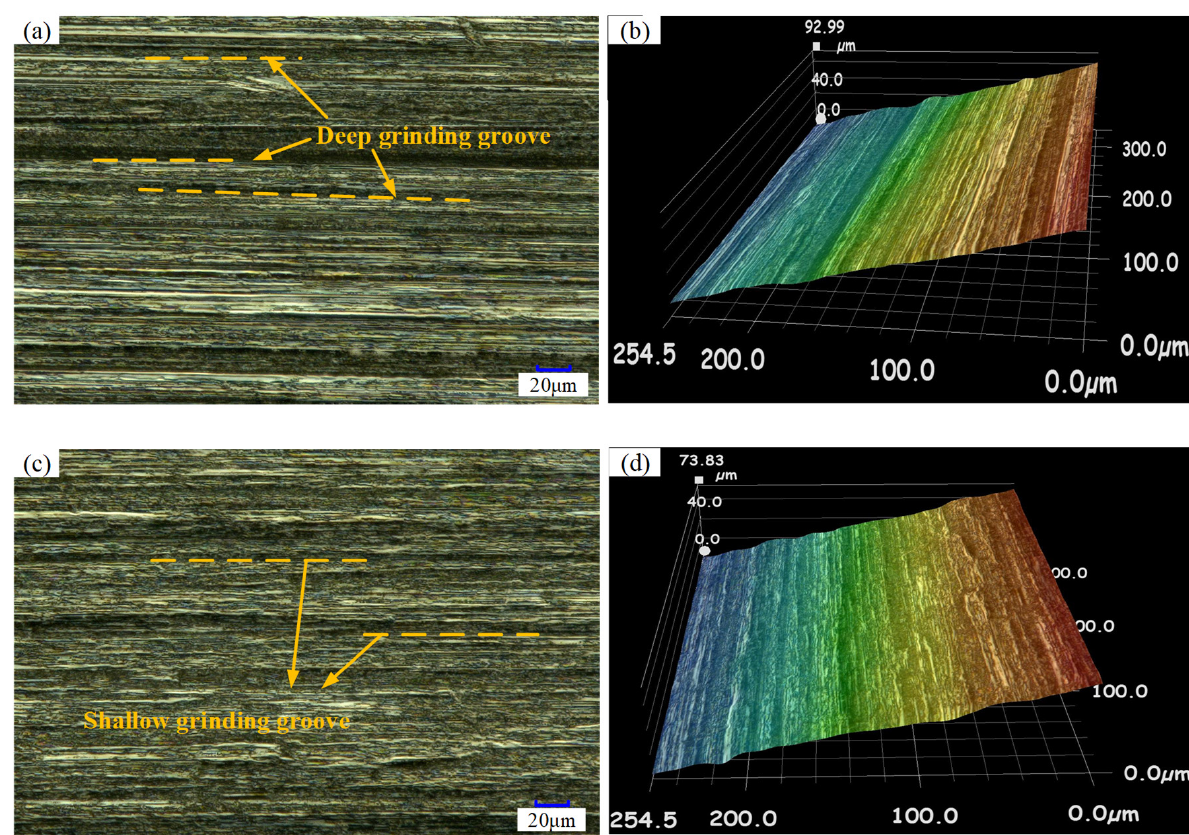
Figure 6. Surface morphology: ( a , b ) C-FGG, ( c , d ) TUVA-FGG.